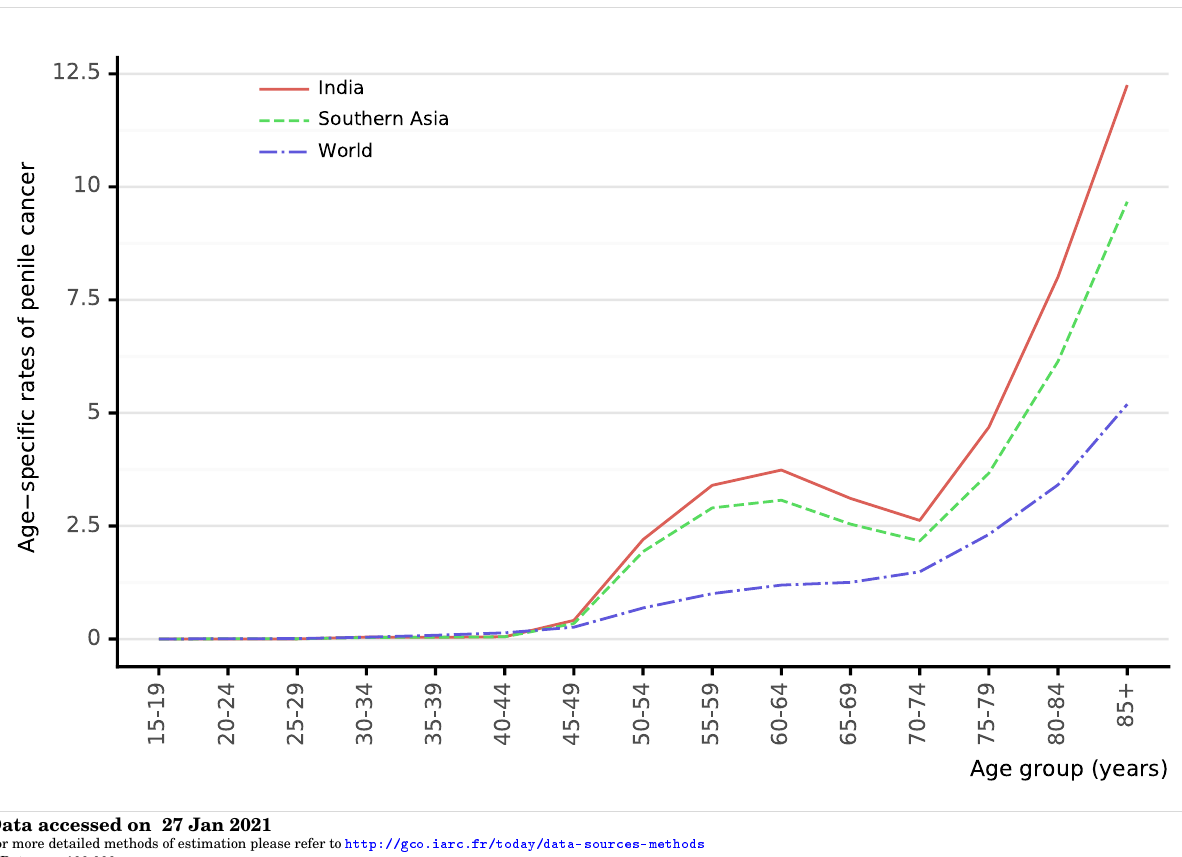
Figure 121: Comparison of age-specific penile cancer mortality rates in India, within the region, and the rest of